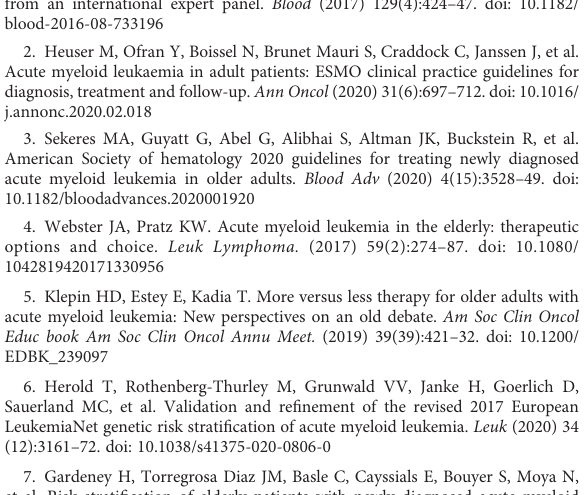
do not show any differential transcriptomic pro fi le respect to non- long survival AML patients with these same genetic alterations. (A-D) Differential expression analysis between long survival AML patients and non-long survival AML patients with (A) NPM1 mutations, (B) RUNX1 mutations, (C) IDH1/2 mutations or (D) TET 2 mutations.